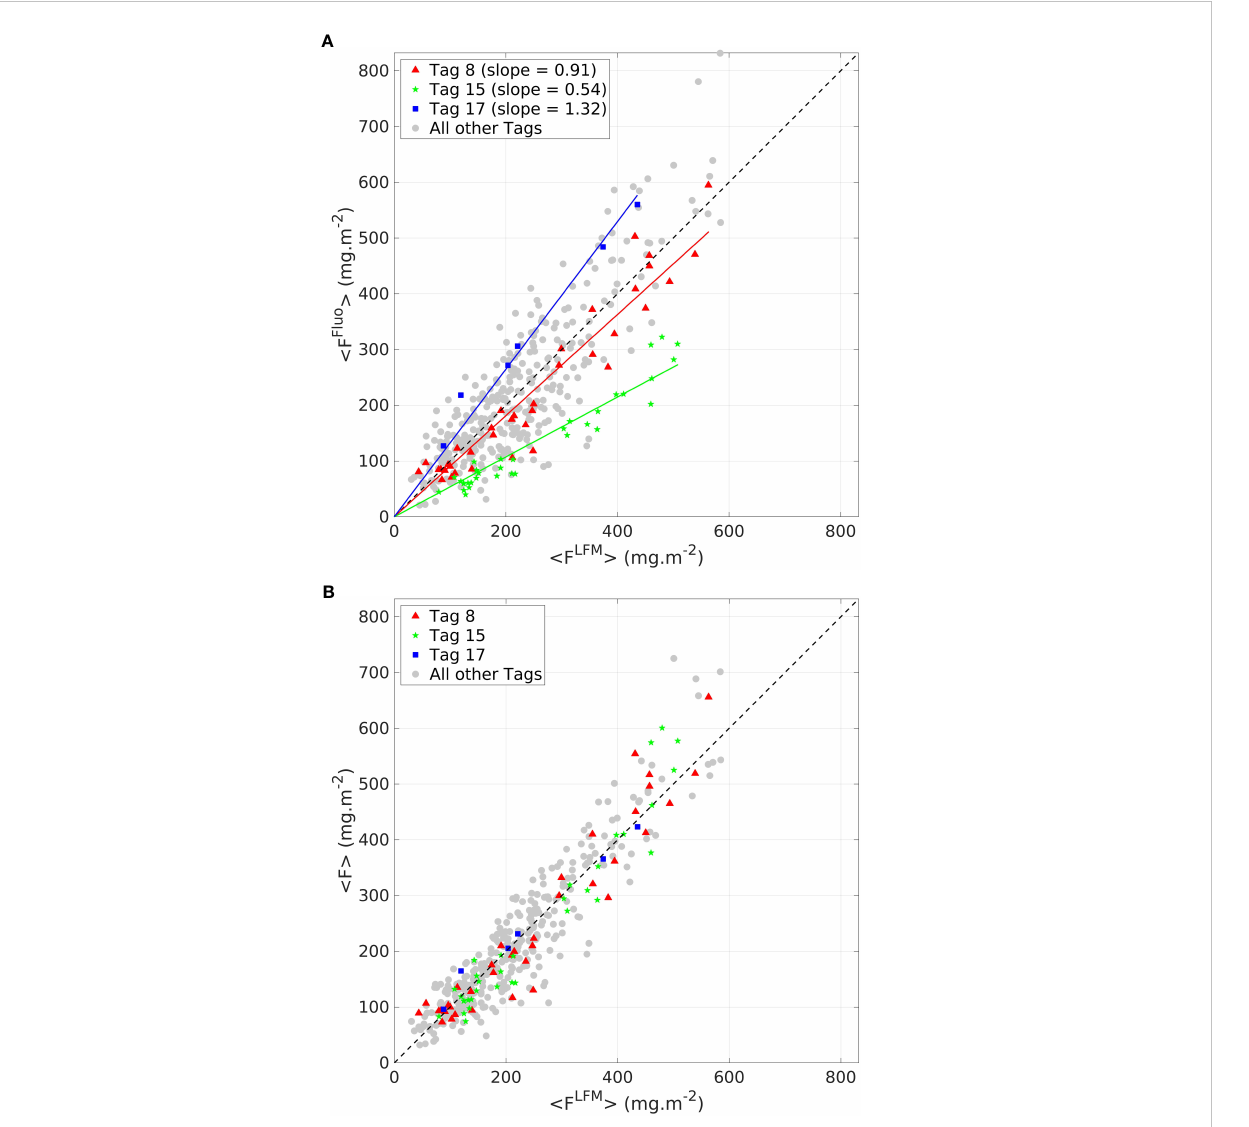
FIGURE 3 Comparison between <F Fluo > and <F LFM > (A) before the LFM-based intercalibration step (B) after the LFM-based intercalibration step. Three tags are highlighted (red triangle, green dots and blue squares, for tags 8, 15 and 17, respectively). Data from all other tags are displayed by gray dots. The black dashed line represents the 1:1 reference